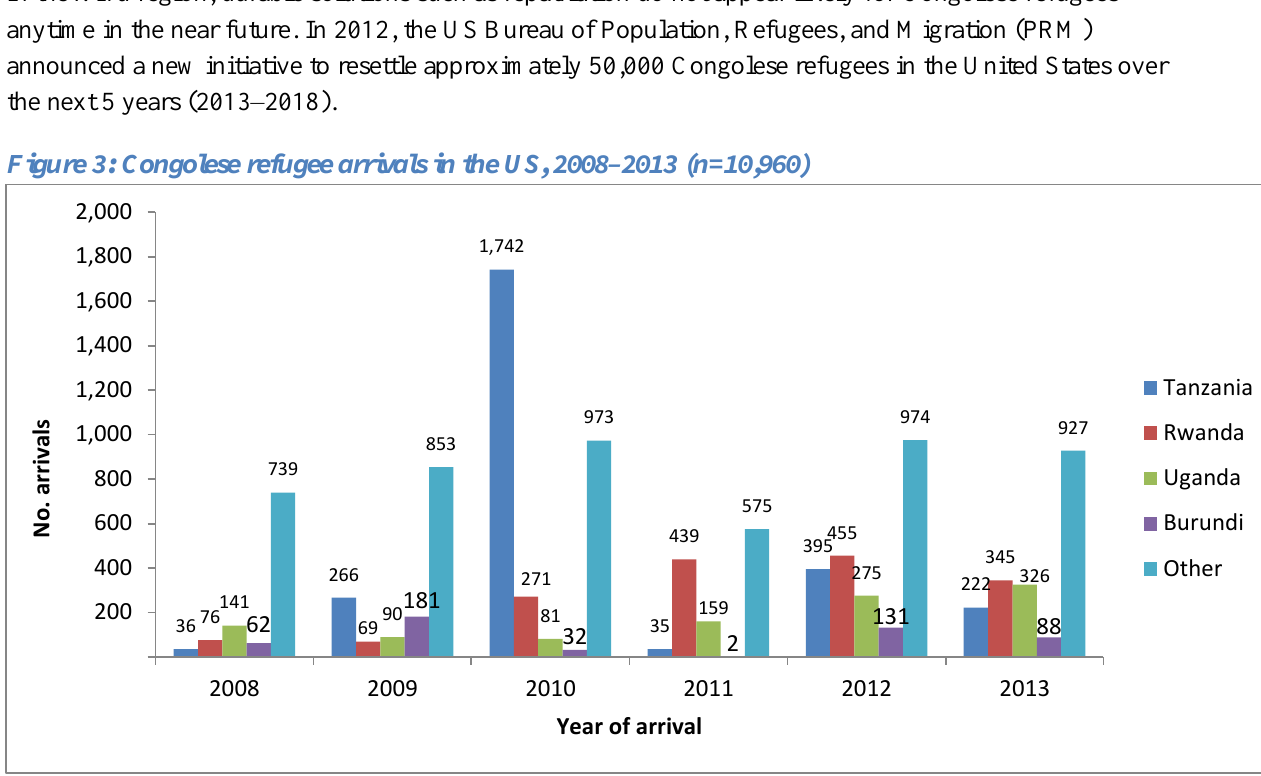
Source: CDC, DGMQ, Electronic Disease Notification system